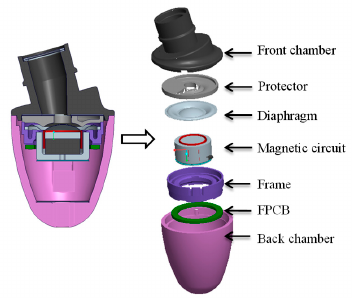
Figure 1. Section view of earphone.